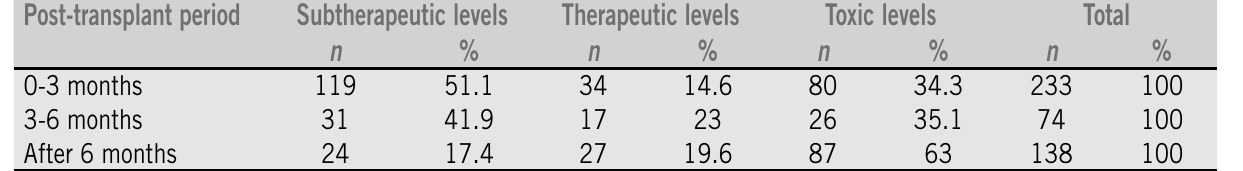
Table 3 Analysis distribution associating blood levels with period after transplant Post-transplant period Subtherapeutic